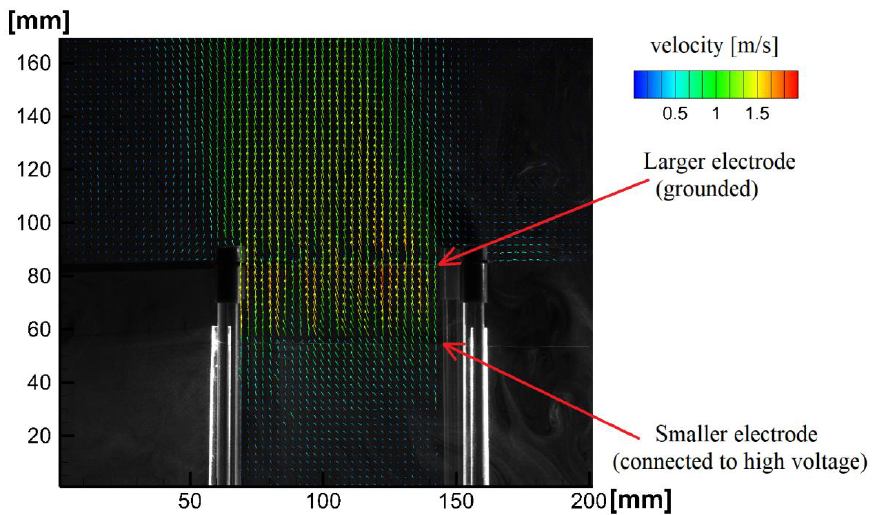
Figure 5 . Vector map of velocities obtained using the PIV method to examine the airflow between the electrodes for the voltage of 14 kV.